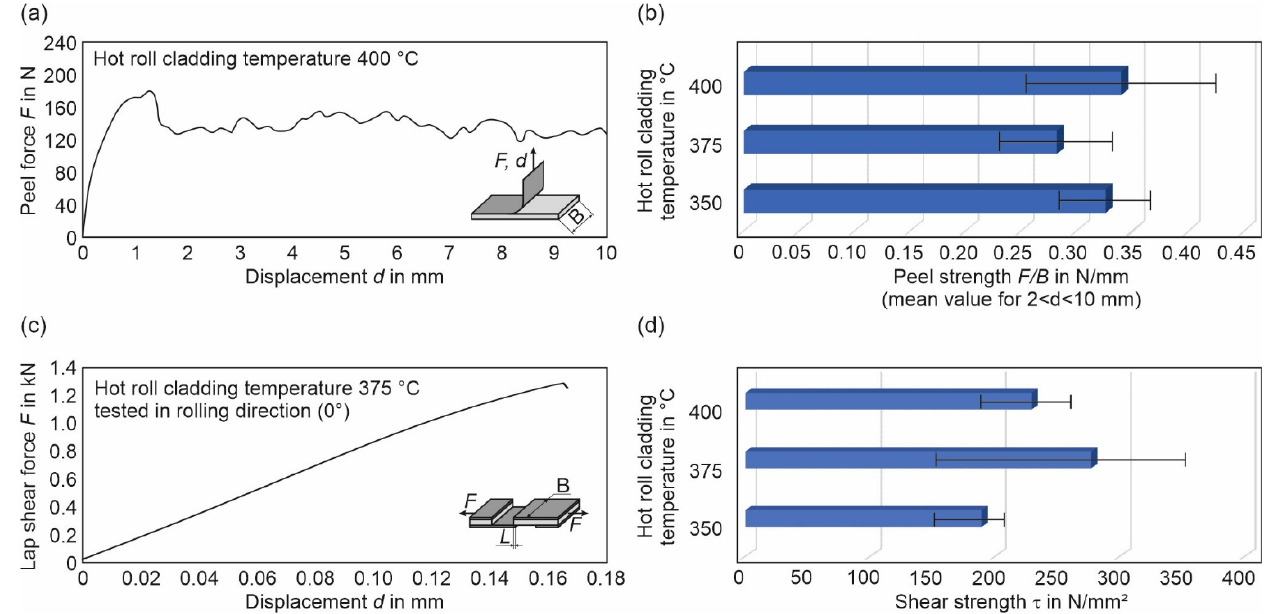
Figure 5. Interlaminar adhesion quality: ( a ) Representative peel force vs. displacement curve; ( b ) Peel strength for different hot roll cladding temperatures; ( c ) Representative shear force vs. displacement curve; ( d ) Shear strength for different hot roll cladding temperatures.